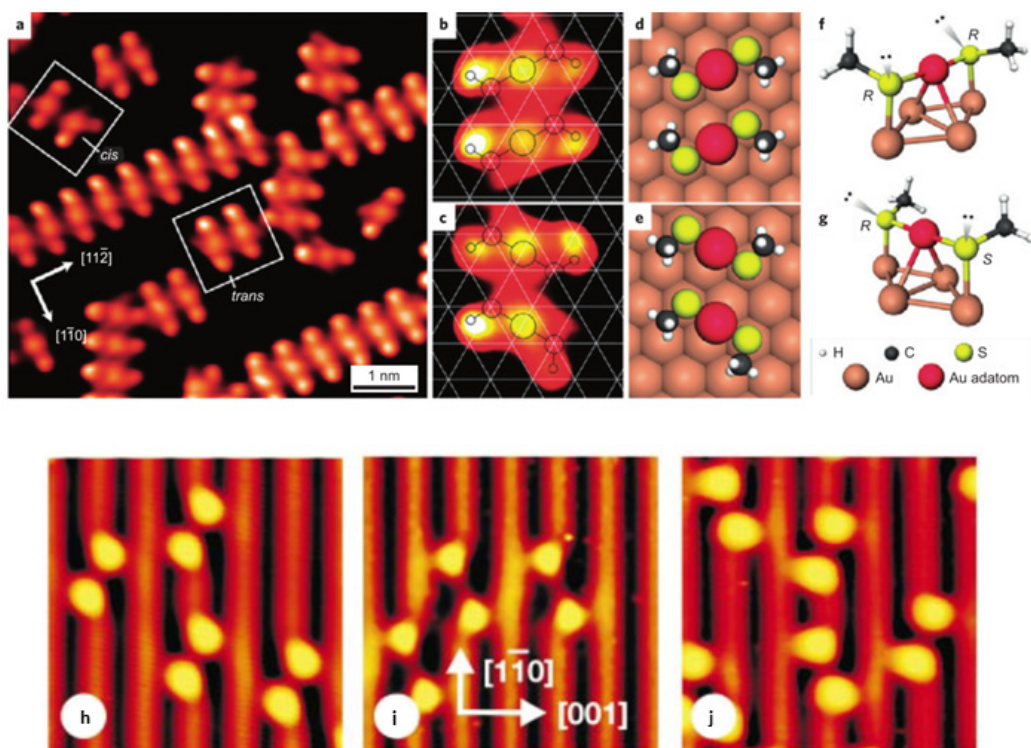
Figure 9 - Selective adsorption of thiols onto Au (111)( a-g ), adapted from (Häkkinen 2012) and Cys case, being h the adsorbed dimer for L-Cys, i for D-Cys and j the dimers for a racemic starting mixture, adapted from (Kühnle et al.